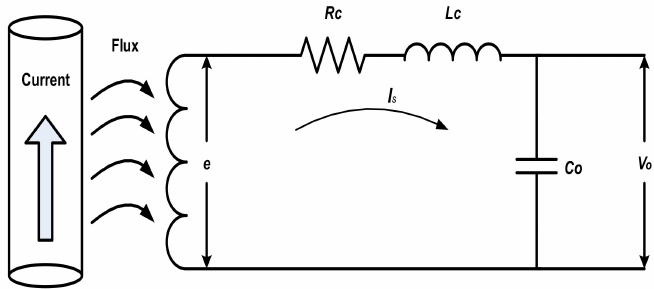
Figure 2. The Equivalent Circuit of a Rogowski Coil